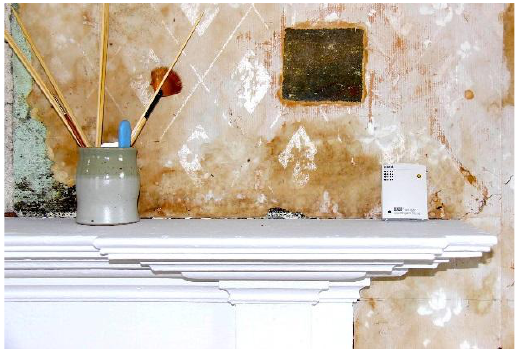
Figure 6: Conservator revealing the painting underneath the wallpaper above the fireplace. Source: Ann